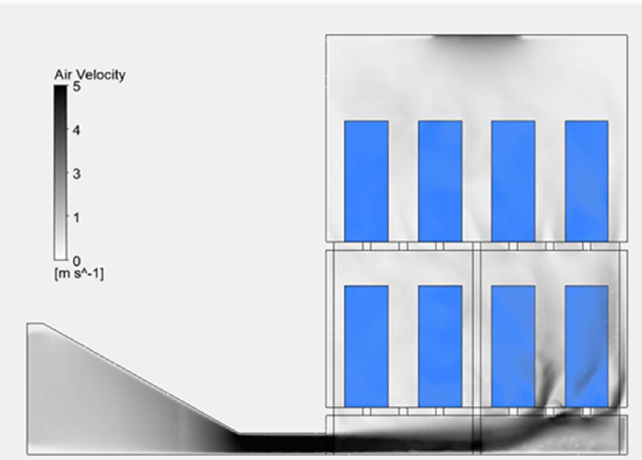
Figure 12. Volumetric representation of air flowing through the default experimental model in simulation. Table 4. Default design experimental and simulation temperature comparison.